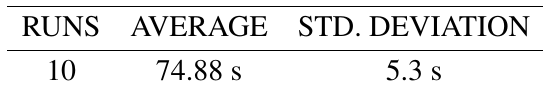
Table 3. Average and Standard Deviation for full exploration time in 10 runs using Avoid Past + 10% wandering rate with 3 robots.